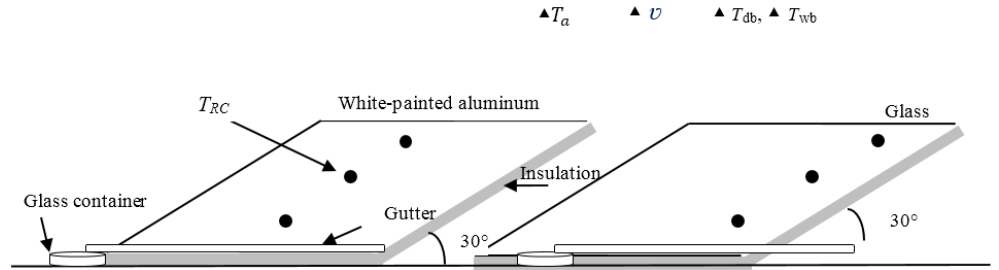
Figure 2. Experimental setup.